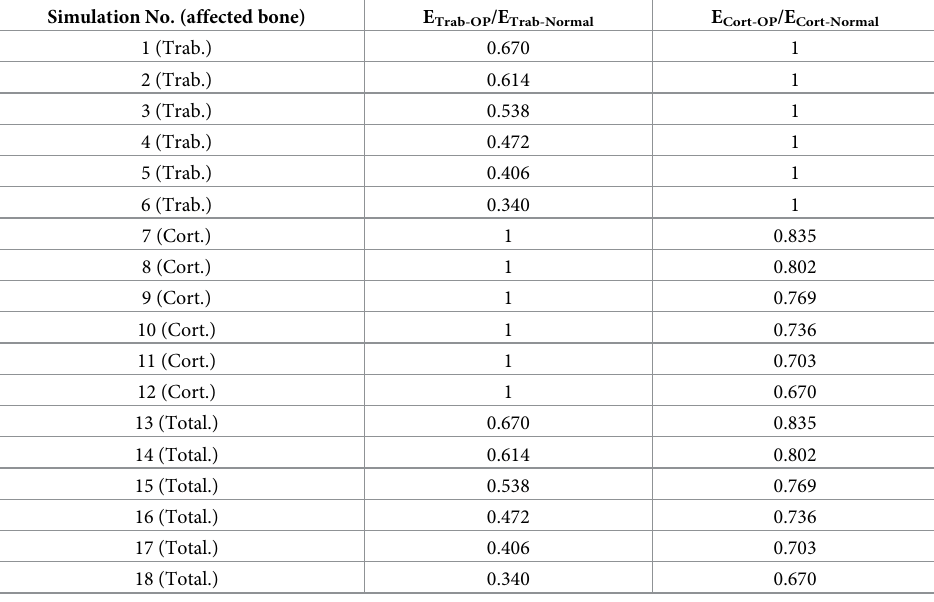
Table 1. Simulated cases with different types and levels of reduction in the elastic modulus. Simulation No. (affected bone) E Trab-OP /E